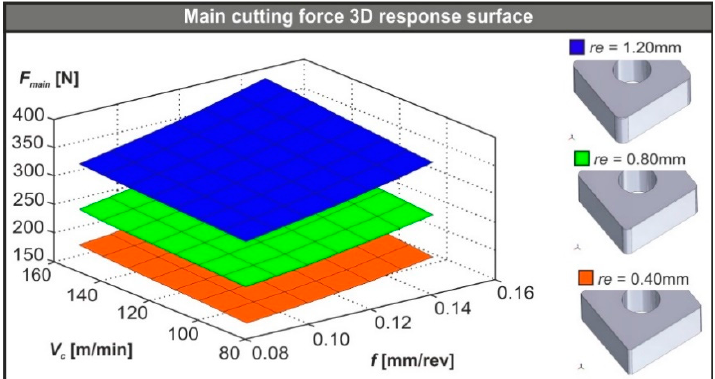
Figure 8. 3D plots of the F main for each nose radius.